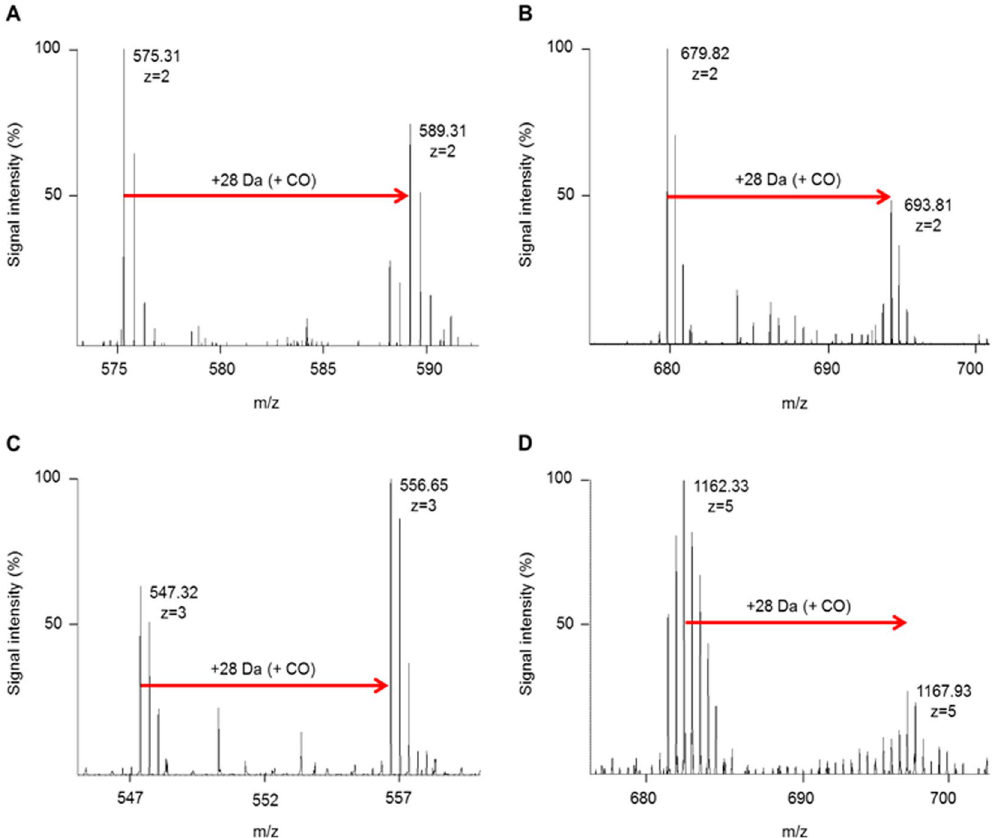
Figure 4. Laser-induced modification of human serum albumin (HSA) peptide standard and insulin. Orbitrap ESI-FTMS mass spectra of laser-induced formylation of HSA standard peptides ( A ) LVNEVTEFAK, ( B ) AVMoxDDFAAFVEK, and ( C ) KVPQVSTPTLVEVSR. Laser-induced formylation of human insulin ( D ) was also observed. The unmodified forms of the peptides and insulin correspond to the first labeled peak in each mass spectrum. The charge state of each peptide or protein observed by electrospray ionization is indicated below the m/z value. The modified forms have a net addition of CO ( + 28 Da). In all cases, modification was conducted in ACN:water (98:2; % v/v), at room temperature in air by 300,000 laser pulses at wavelength 386 nm with average pulse energy 269.5 μ J at intensity 5.19 × 10 10 W cm − 2